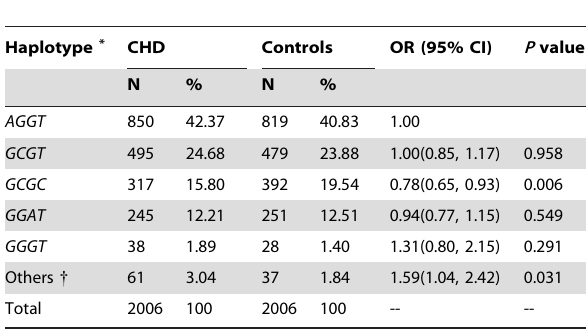
Table 4. Haplotype distribution of HSPA8 in CHD and control